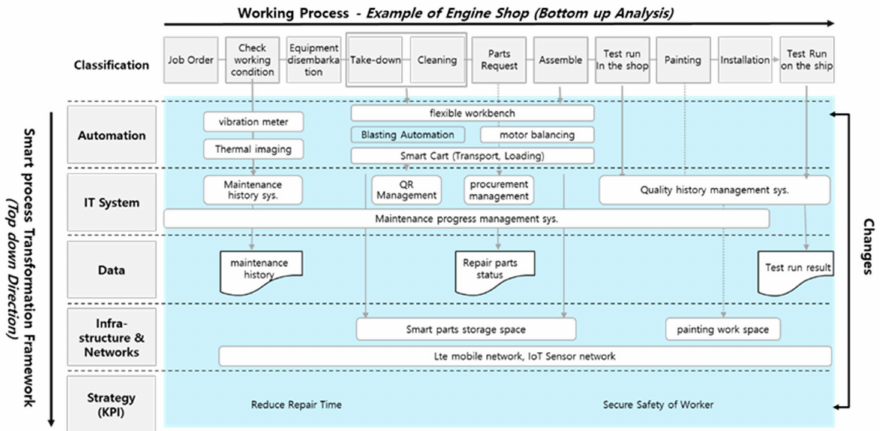
Figure 7. Example of requirements analysis for smart